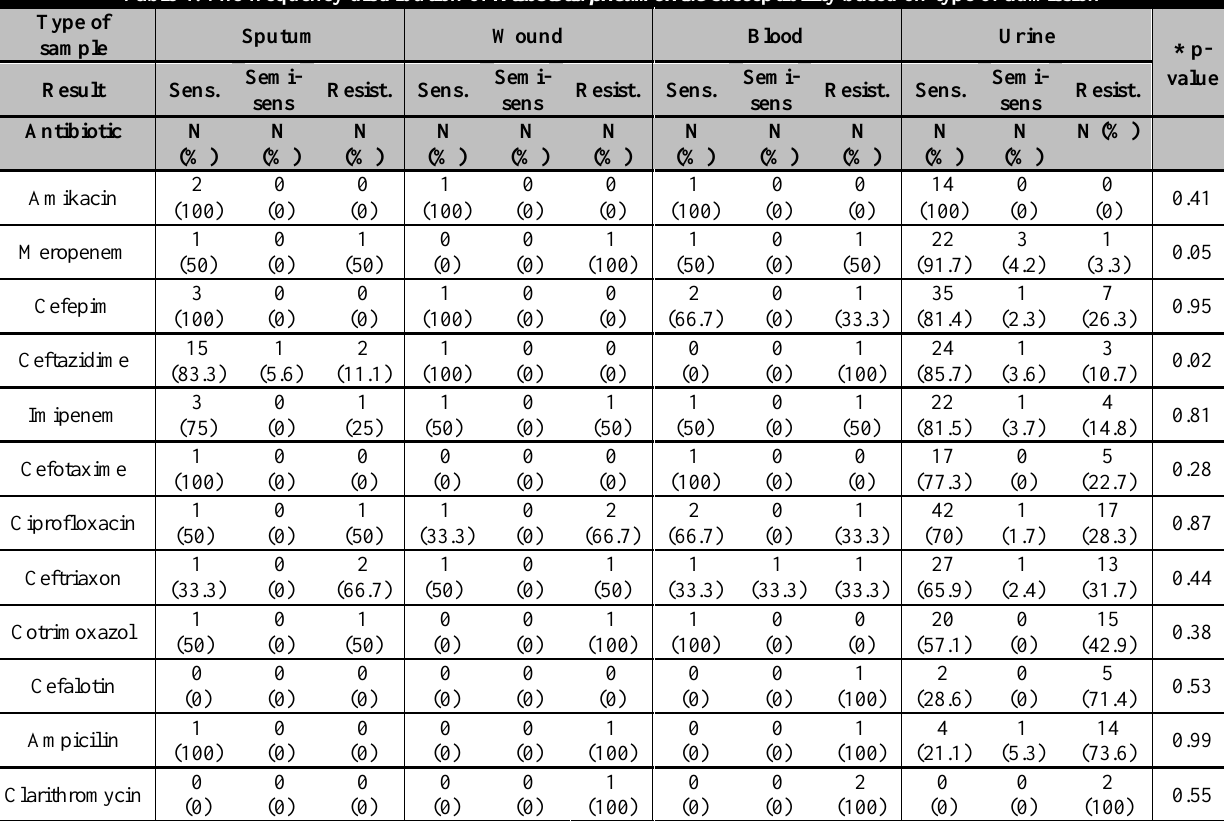
Table 4. The frequency distribution of Klebsiella pneumoniae susceptibility based on type of admission Type of sample